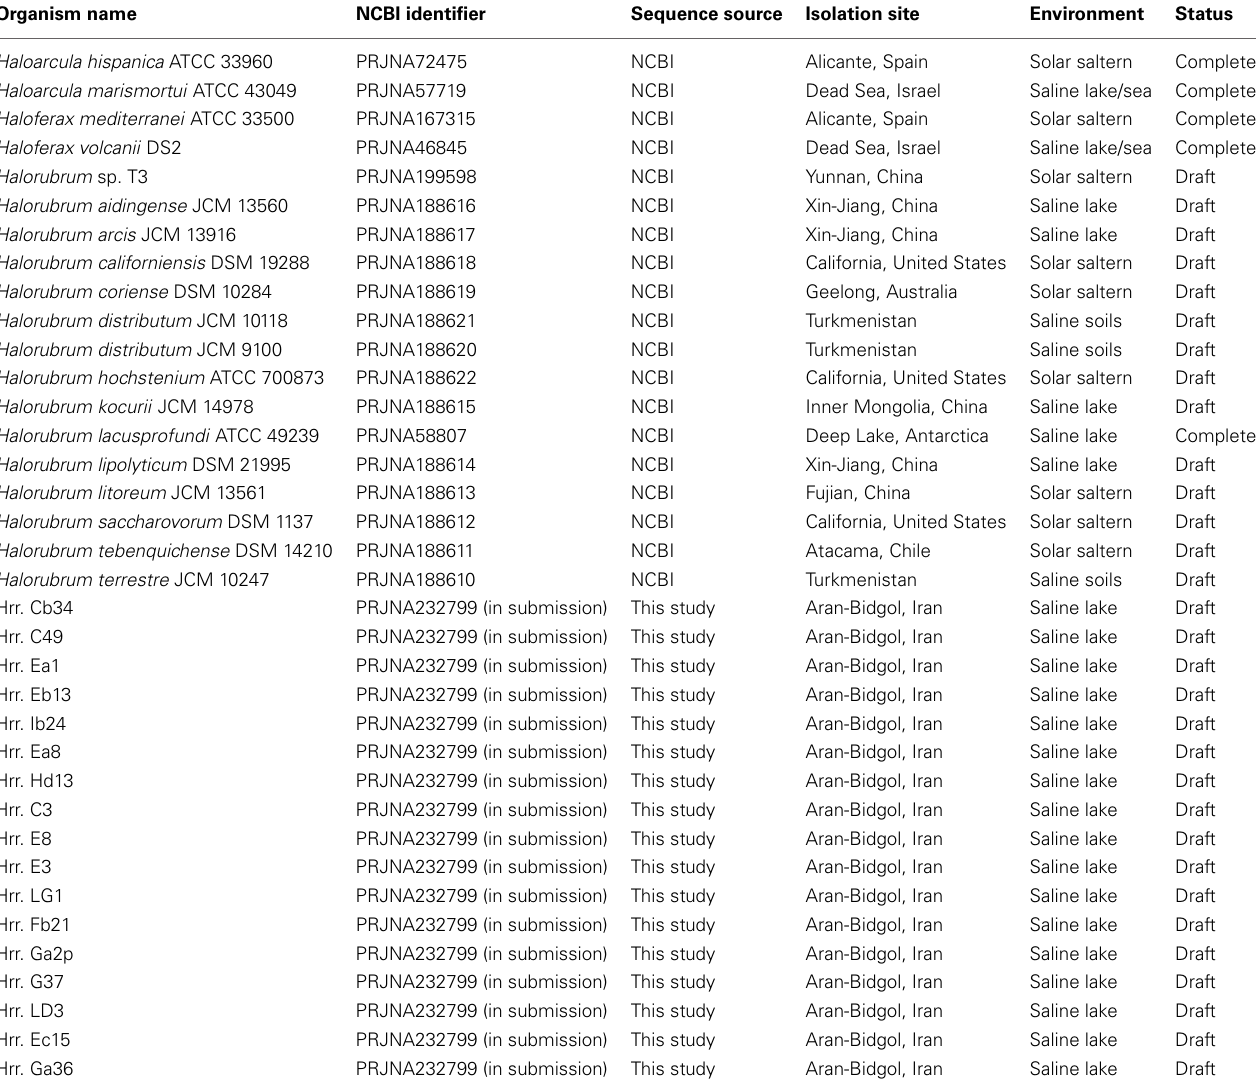
Table 4 | List of genomes used in this